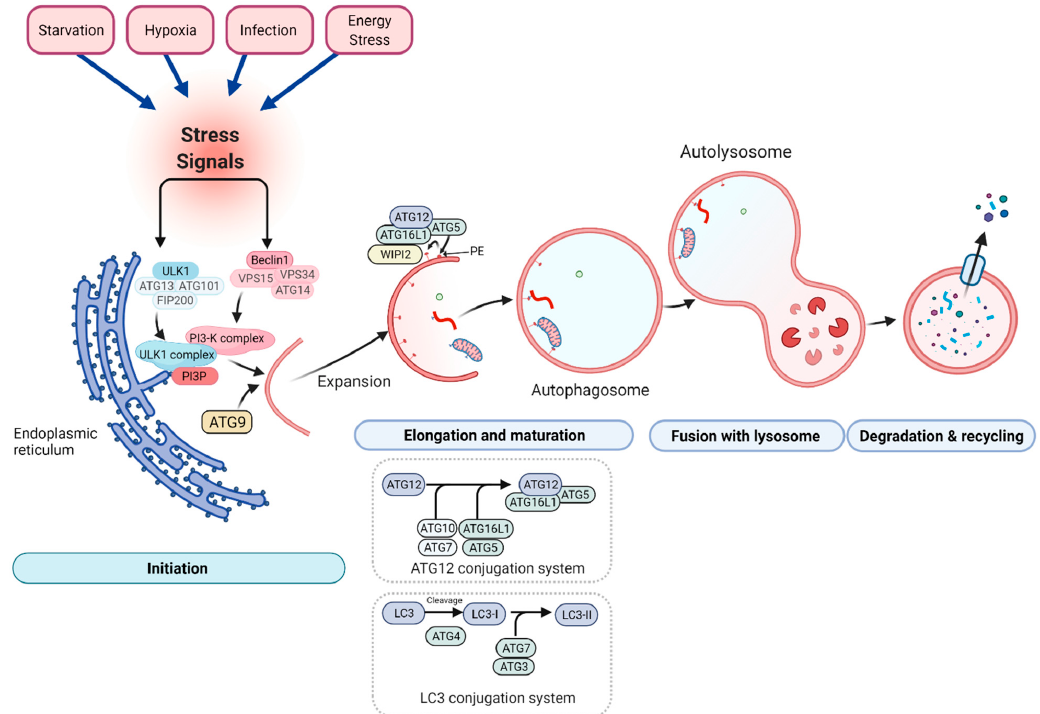
Figure 2. Schematic representation of the autophagy machinery. Autophagy consists of several stages: initiation, elongation and maturation, fusion to lysosome, and degradation and recycling. Autophagy is initiated by stress signals (top section). Both the Unc-51 Like Autophagy Activating Kinase (ULK1) and phosphatidylinositol-3 kinase (PI3-K) complexes are essential for initiation of the phagophore. ATG9 is involved in the delivery of lipids for the phagophore’s membrane expansion. The elongation and the maturation of the autophagosomal membrane are dependent on two ubiquitin-like conjugation systems, the ATG12 and microtubule-associated protein light chain 3 (LC3) conjugation systems. The first conjugation system requires ATG12, ATG5, ATG7, ATG10, and ATG16L1 proteins. This system works as E3-like enzymes for the second LC3 conjugation system. The LC3 conjugation system requires ATG4, ATG7, and ATG3 enzymes. Both conjugation systems are essential for the elongation and maturation of the autophagosome. The WD Repeat Domain, Phosphoinositide Interacting 2 (WIPI2) protein also promotes conjugation of LC3 with ATG16L1. Created with BioRender.com.